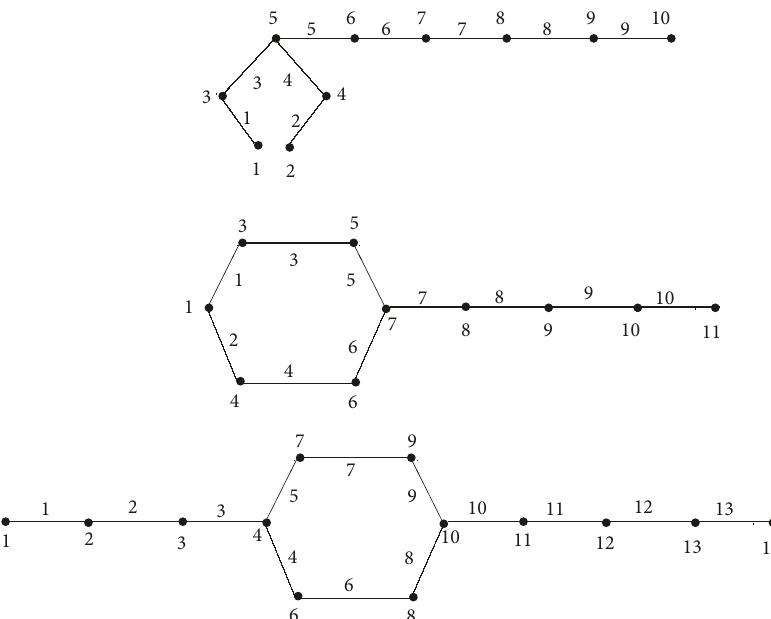
Figure 2: A classical mean labeling of G obtained by duplicating an edge of a path.